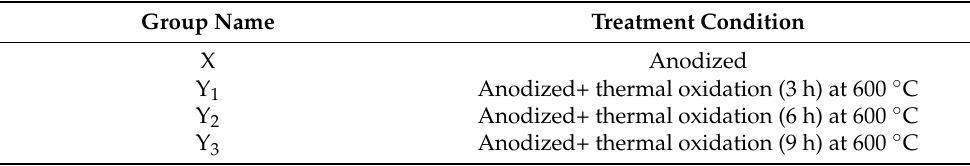
Table 1. Treatment methods and sample